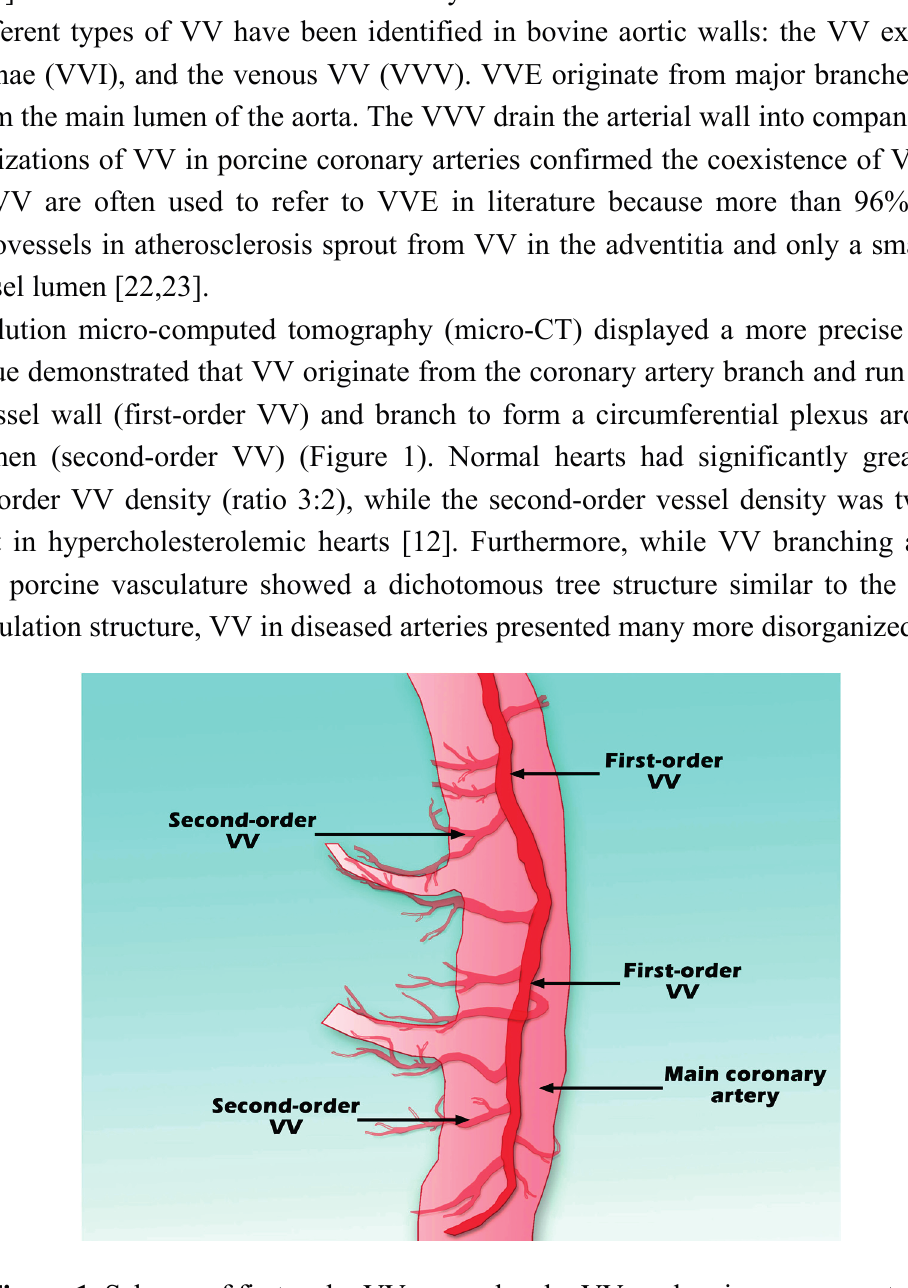
Figure 1. Scheme of first-order VV, second-order VV, and main coronary